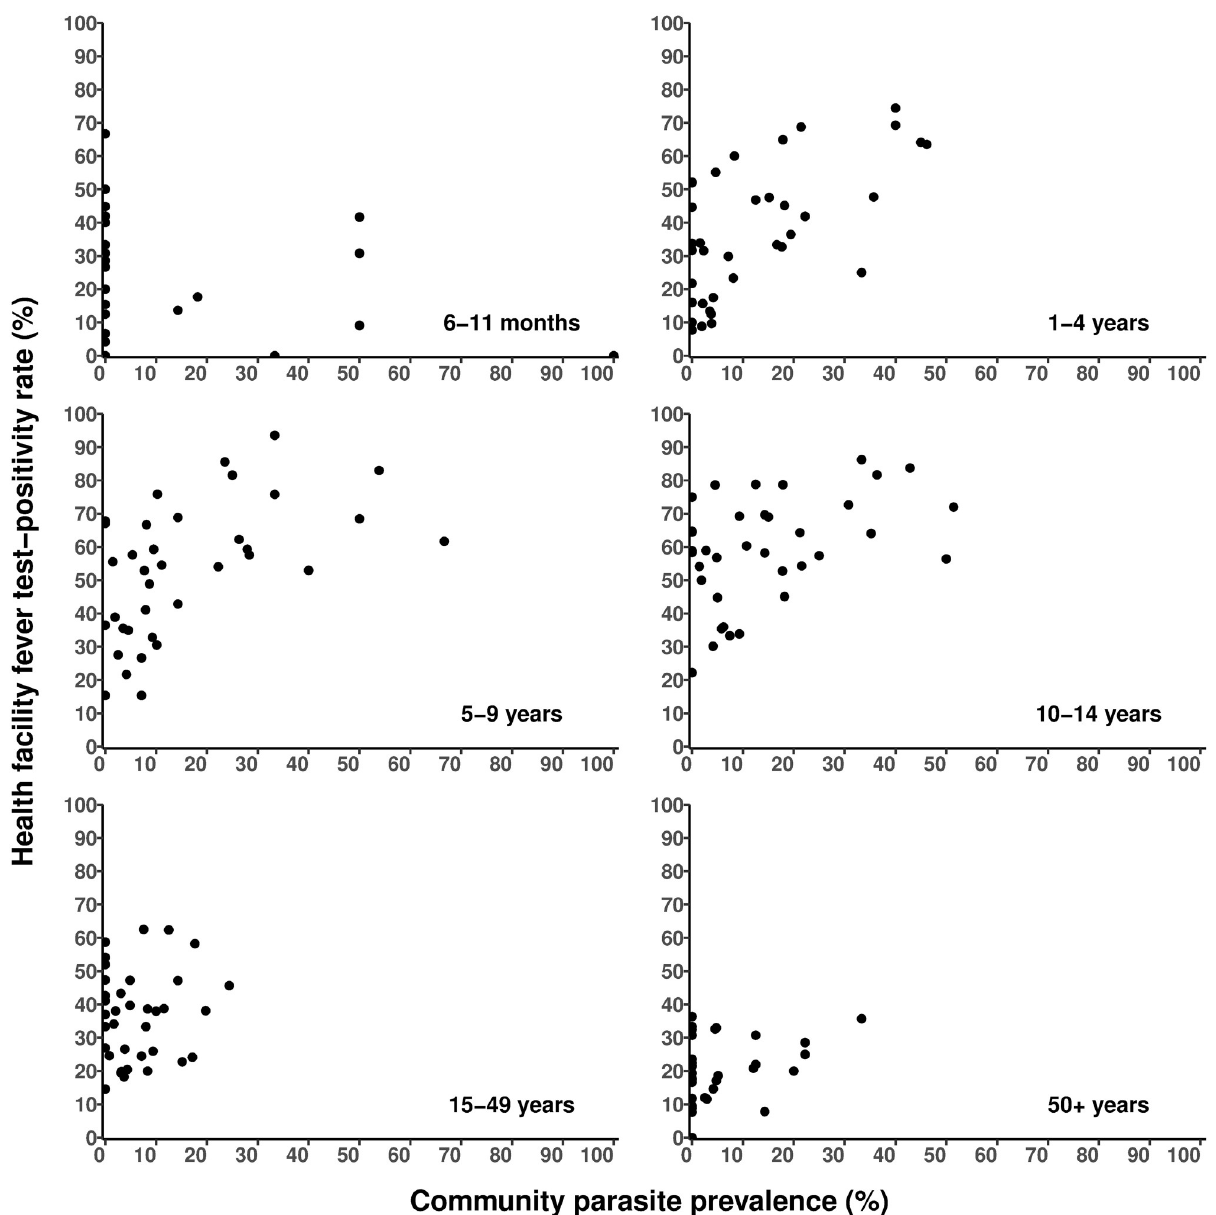
Fig 2. The relationship between health facility Test-Positivity Rate (TPR) (matched to 2 months period around each cross-sectional surveys) and community parasite prevalence (PR) stratified by age group.